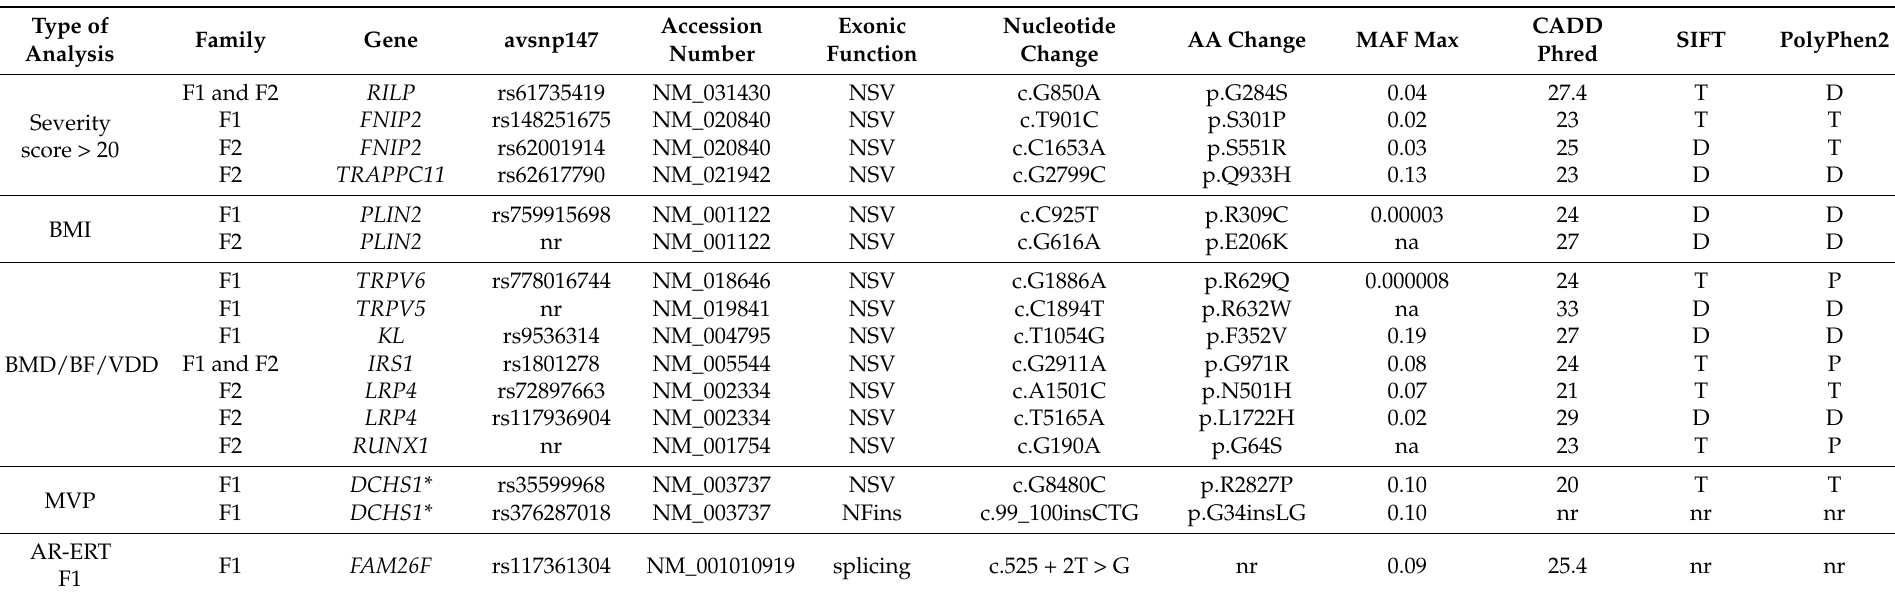
Table 5. List of the rare and deleterious variants identified in the two